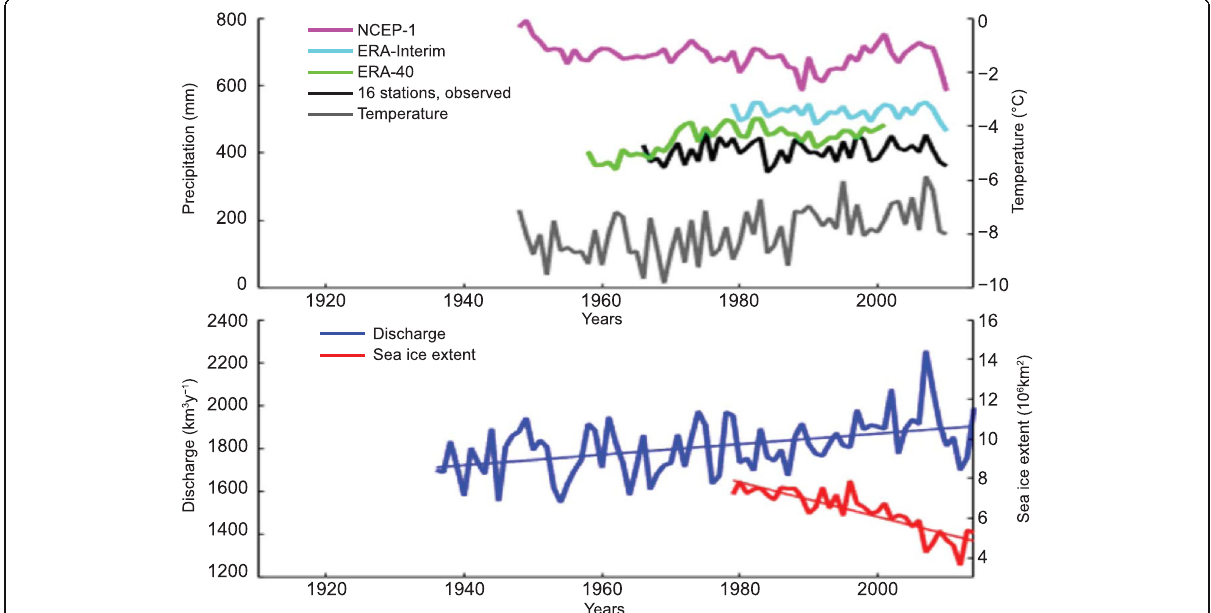
Fig. 10 Top panel: annual precipitation and surface air temperature in Siberia (east of the Ural Mountains, excluding Chukotka) from 18 Siberian stations and reanalysis fields. Lower panel: total annual river discharge to the Arctic Ocean from the six largest rivers in the Eurasian Arctic for the observational period 1936 – 2014 (Holmes et al. 2015) and annual minimum sea ice extent for 1979 – 2014 (source of the sea ice extent data: US National Snow and Ice Data Center, Boulder, CO, USA website,